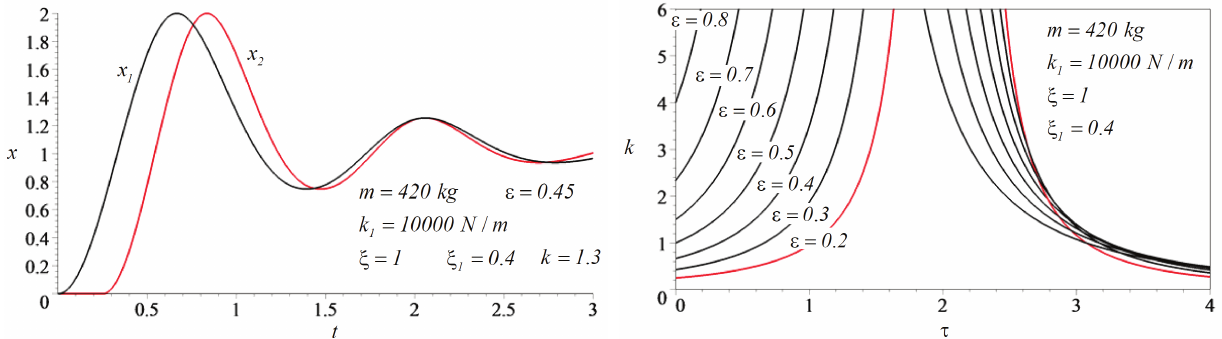
Figure 3. Response of the front and rear suspension of a near flat ride car with ideal nonlinear damper to a unit step input.